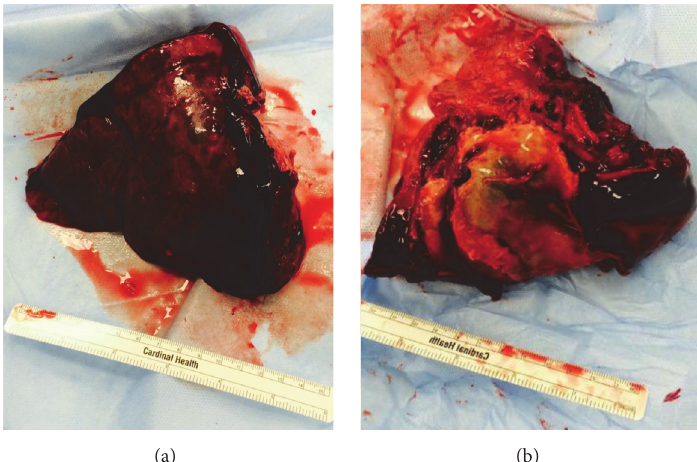
Figure 2: Gross pathology of consolidated fungal mass removed from lung of an 18-year-old male status after cadaveric kidney transplant. (a) Anterior and (b) posterior views of left lower lobe demonstrating a large consolidated fungal mass surrounded by area of hemorrhagic necrosis.